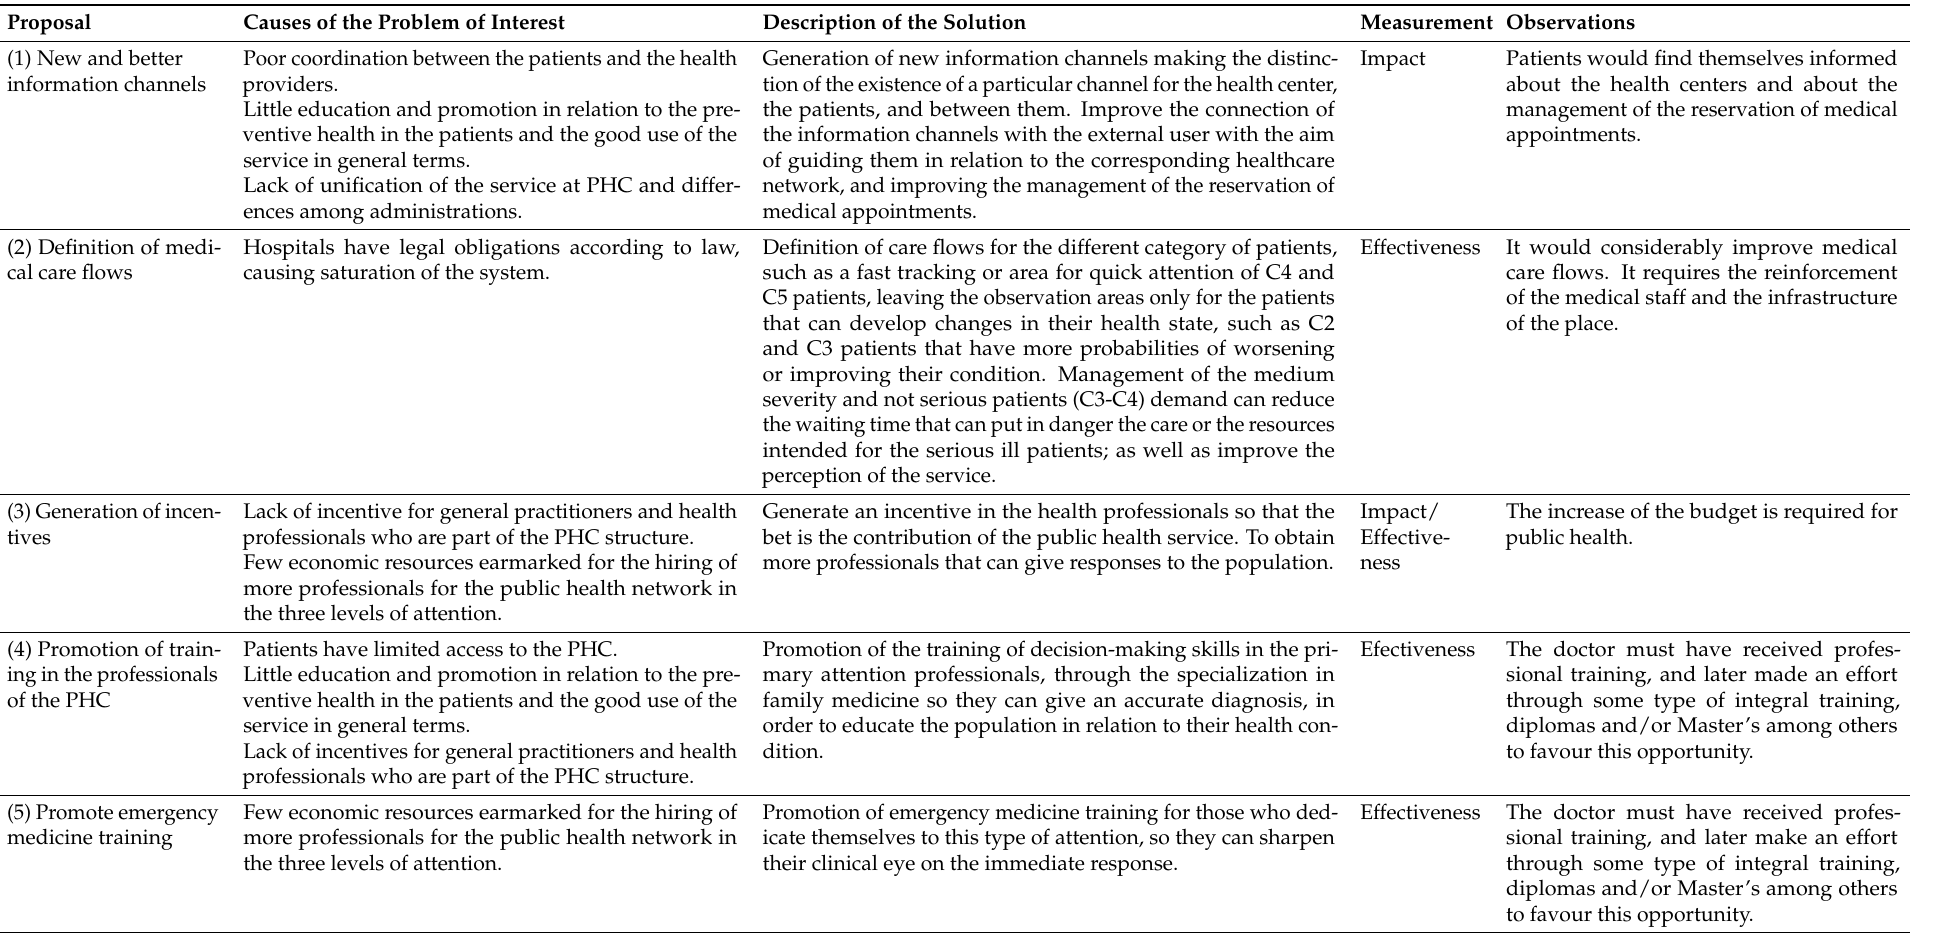
Table 4. Proposal, Description, Measurement and Observations of the detected